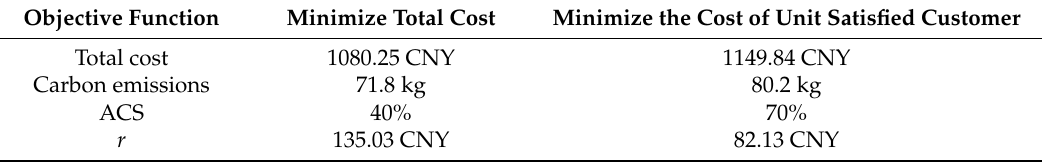
Table 6. Comparison of results.